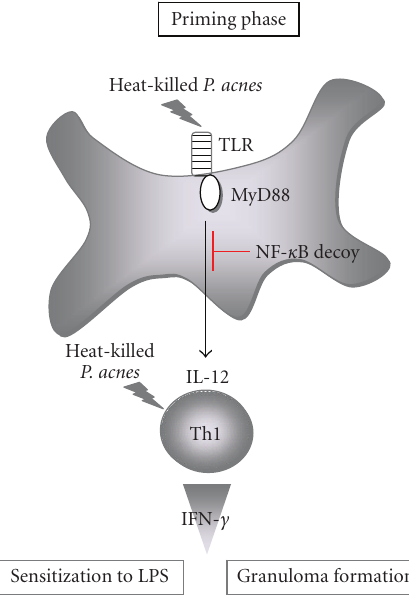
Figure 5: Molecular and cellular mechanisms underlying P. acnes - induced sensitization to LPS. After recognition of heat-killed P. acnes , cytoplasmic domain of TLR9 recruits MyD88 and relays a signal for nuclear translocation of NF- κ B, eventually resulting in various gene expressions including IL-12 production. IL-12 is involved in the development of P. acnes -specific Th1 cells, which produce robust IFN- γ in response to P. acnes . IL-12 also activates hepatic NK cells to release IFN- γ . IFN- γ derived from Th1 cells and NK cells sensitize mice to LPS and induce their dense hepatic granuloma formation. Administration of NF- κ B decoy profoundly inhibits both the LPS sensitization and the hepatic granuloma formations